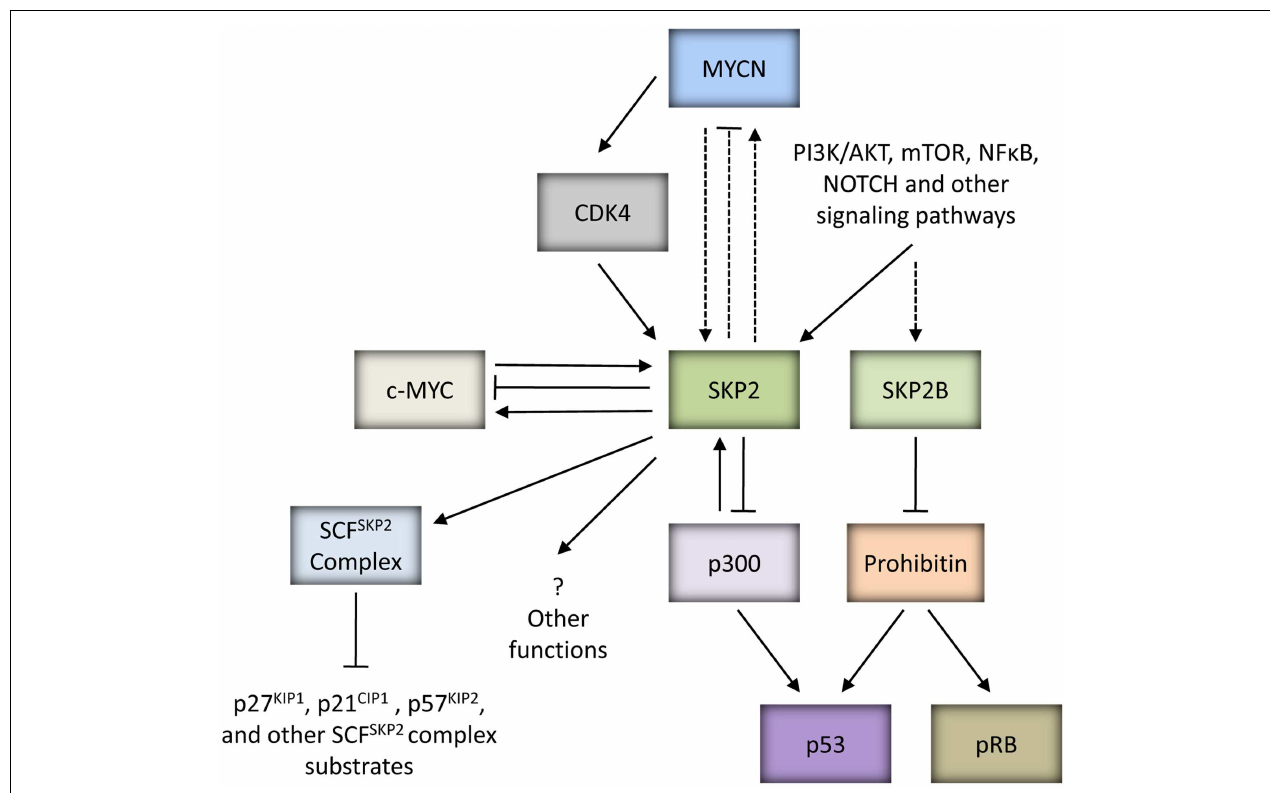
linked to carcinogenesis such as PI3K/AKT and mTOR have been shown to influence SKP2 expression, stability and SCF SKP2 ligase activity. SKP2 is a component of the SCF SKP2 complex which mediates the degradation of several substrates including CDK inhibitors p21 CIP1 , p27 KIP1 , and p57 KIP2 . Independently of SCF complex formation, SKP2 can bind to p300 and attenuate p53 function. Interestingly, p300 is able to reciprocally regulate SKP2 activity. SKP2B, an alternatively spliced variant of SKP2 , can perturb both p53 and pRB pathways via degradation of Prohibitin. It is possible that SKP2 has other functions which may promote